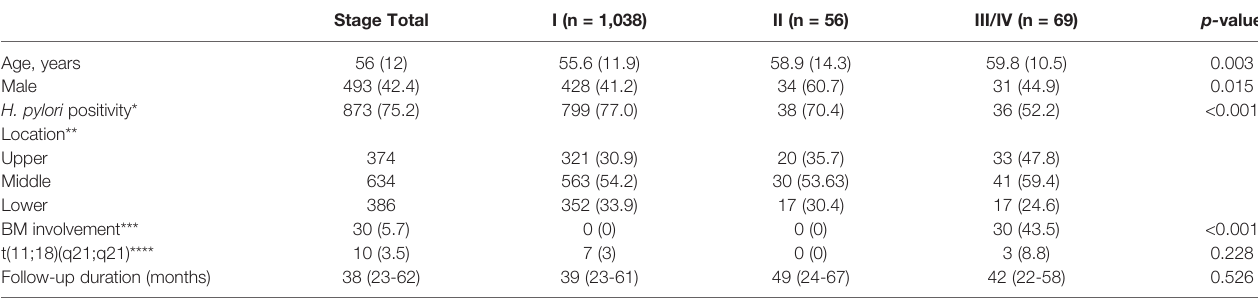
TABLE 1 | Clinical characteristics of patients diagnosed with gastric MALT